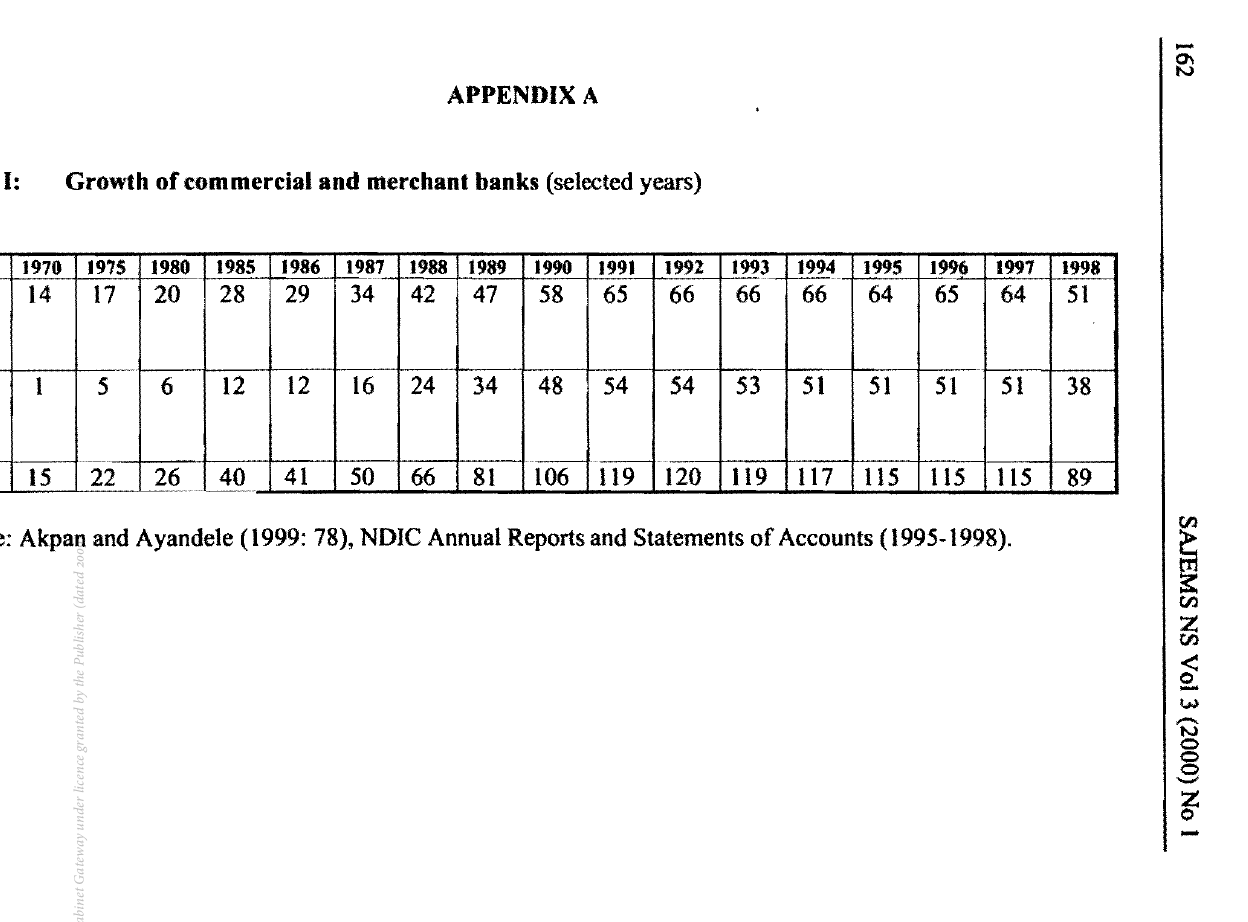
Growth of commercial and merchant banks (selected